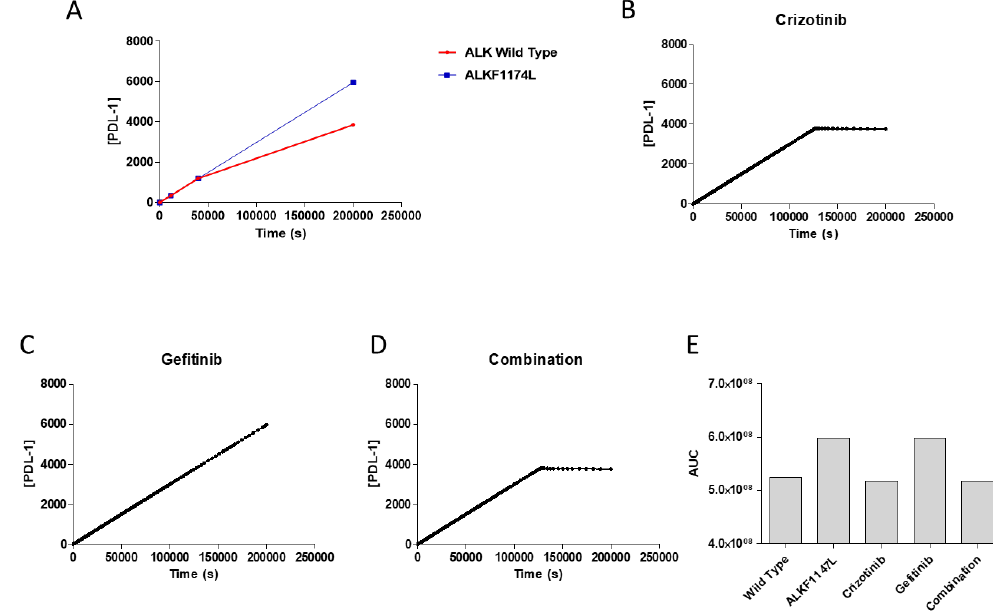
Figure 4. Expression of PD-L1 in a neuroblastoma cell line with and without ALK mutation ( A ). ( B ) Expression of PD-L1 after treatment with 1.4 × 10 −3 mM crizotinib therapy ( C ), 3 × 10 −3 mM gefitinib therapy ( D ) and a combination of the two inhibitors ( E ). The simulation was conducted from 0 to 2 × 10 5 s., using the deterministic (LSODA) method. All concentrations are in mmol/mL. Comparison of the cumulative area under the curves (AUCs) of PD-L1 expression without therapy and with different therapy regimens ( F ).